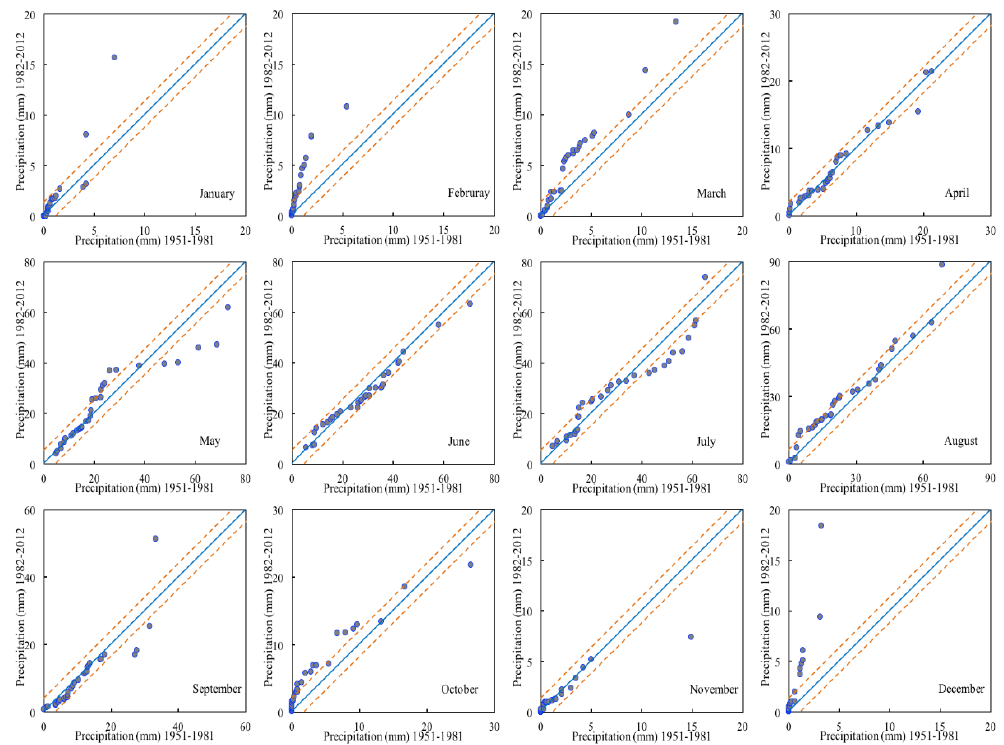
Figure 3. The results of applying the ITA method for monthly precipitation at the Balykchy station in the Lake Issyk-Kul basin 1951–2012.